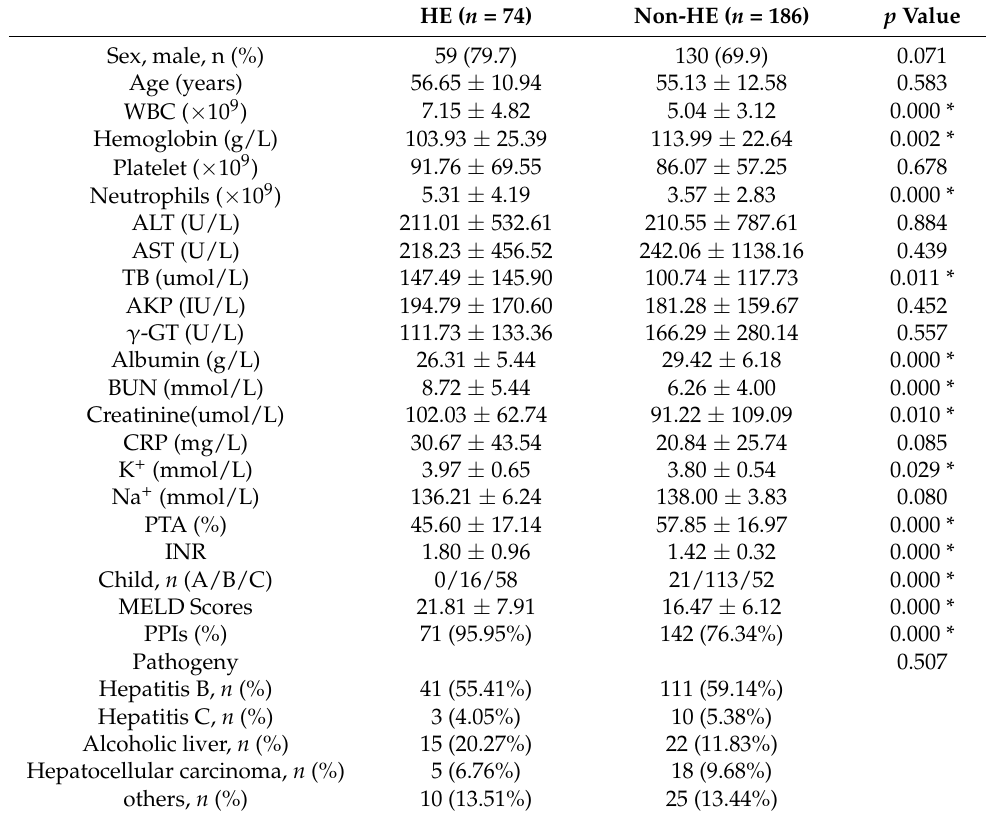
Table 3. Clinical manifestations and laboratory results at